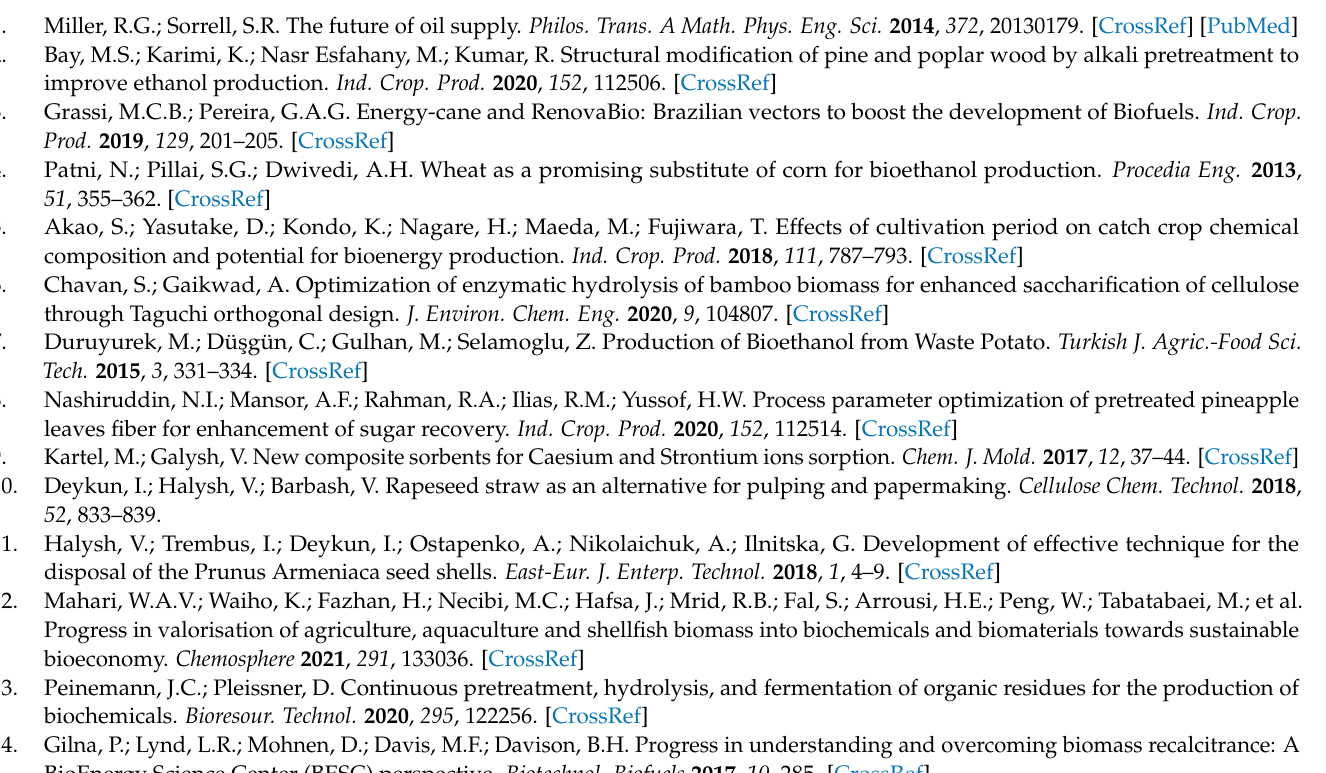
124, 110, 109, 108, 107, 94, 91, 78, 60, and 55 obtained via pyrolysis of the solid based on apricot seed shells after acid pretreatment; Figure S3: TPD curves for ions with m/z 154, 138, 136, 124, 110, 109, 108, 107, 94, 91, 78, 60, and 55 obtained via pyrolysis of the solid based on apricot seed shells after pretreatment with steam explosion; Figure S4: TPD curves for ions with m/z 154, 138, 136, 124, 110, 109, 108, 107, 94, 91, 78, 60, and 55 obtained via pyrolysis of the solid based on walnut shells after alkaline pretreatment; Figure S5: TPD curves for ions with m/z 154, 138, 136, 124, 110, 109, 108, 107, 94, 91, 78, 60, and 55 obtained via pyrolysis of the solid based on walnut shells after acid pretreatment; Figure S6: TPD curves for ions with m/z 154, 138, 136, 124, 110, 109, 108, 107, 94, 91, 78, 60, and 55 obtained via pyrolysis of the solid based on walnut shells after pretreatment with steam